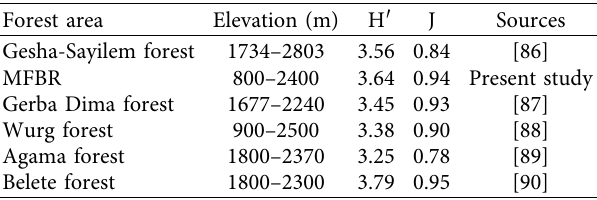
Table 13: Comparisons of the Shannon diversity index and evenness of MFBR with other moist Afromontane forests in southwestern